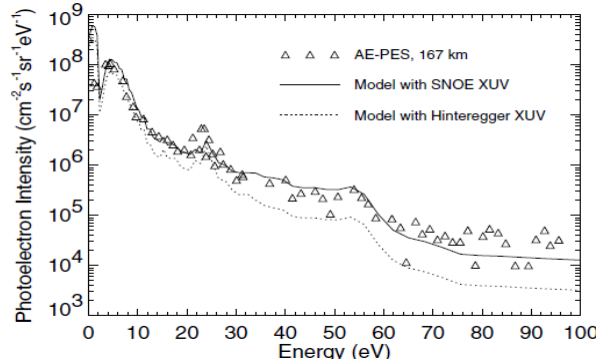
(NOAA and UARS/SOLSTICE); San Marco satellite (SM); Up-